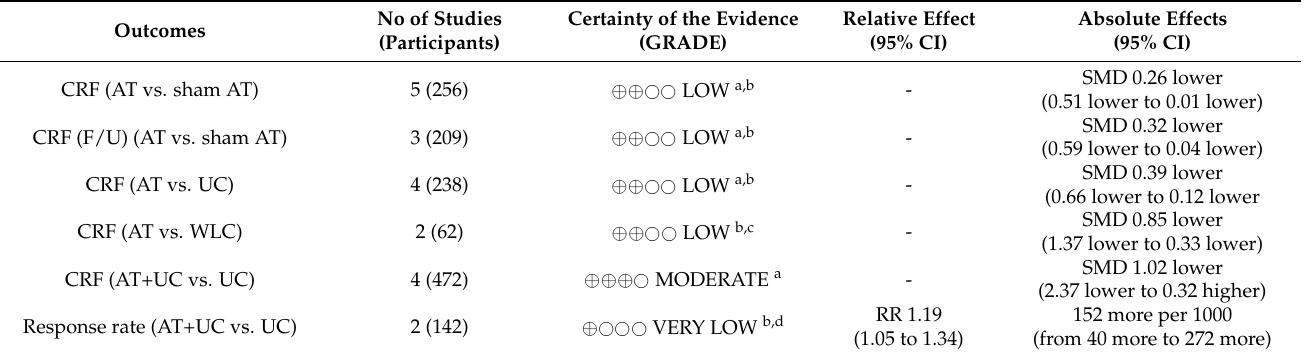
Table 3. Summary of